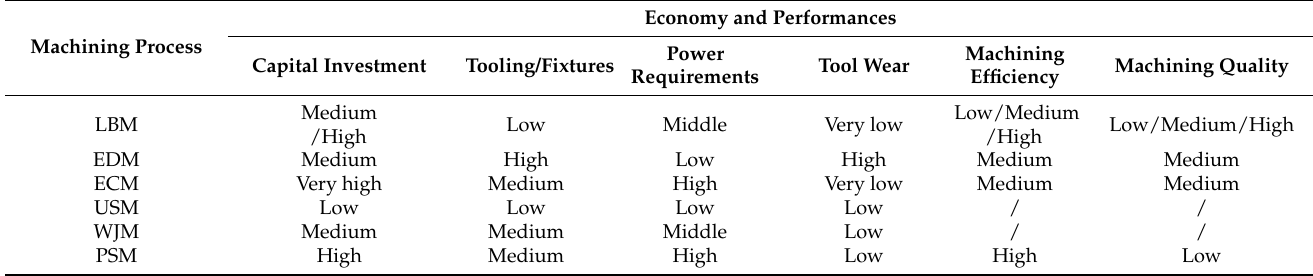
Table 5. Relative comparisons of different non-traditional machining processes for fabricating superhydrophobic surfaces.